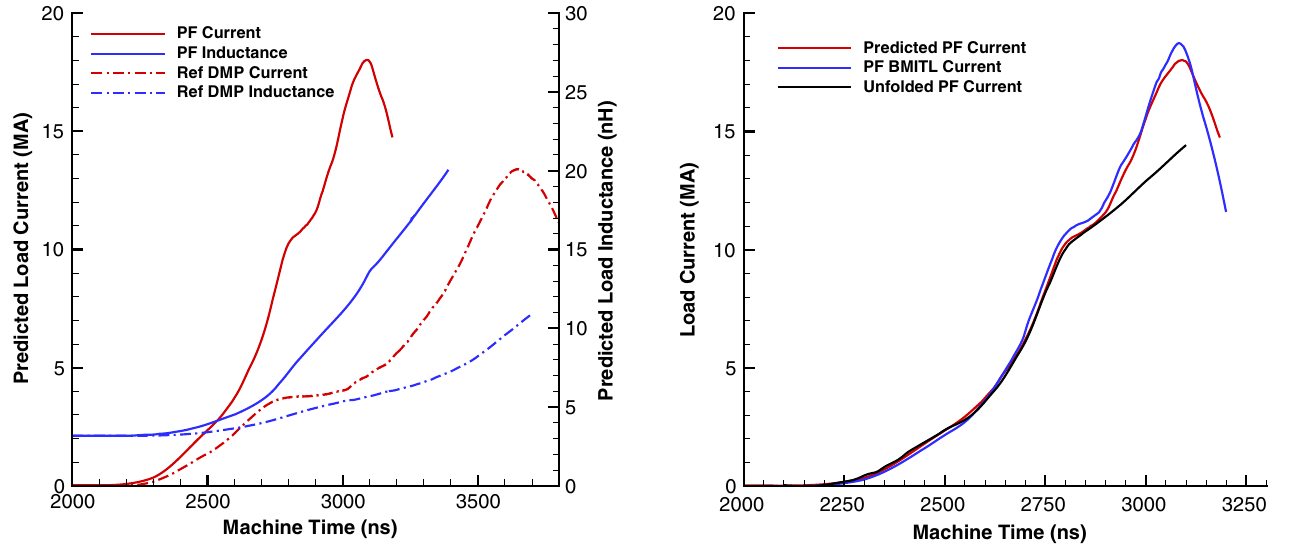
FIG. 4. Plot of predicted current for the PF target along with the experimental current measured by the MITL B-dots and the best attempt at unfolding the load current from target velocimetry using experimental data obtained from